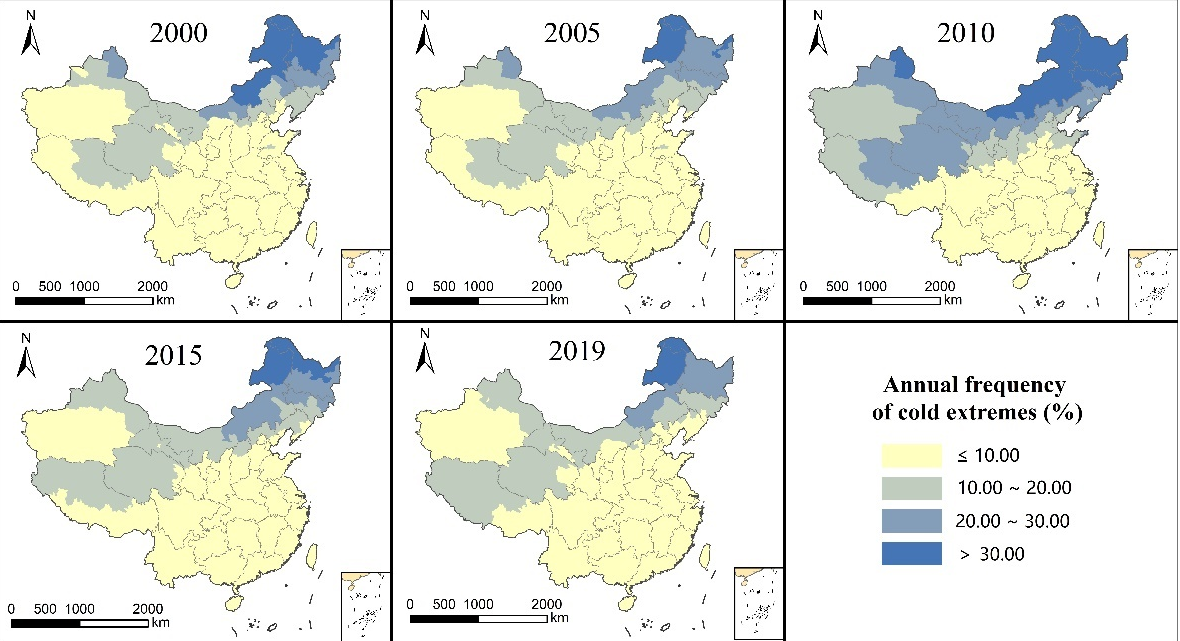
Figure 4. Annual frequency distribution of thermal extremes in China from 2000 to 2020.